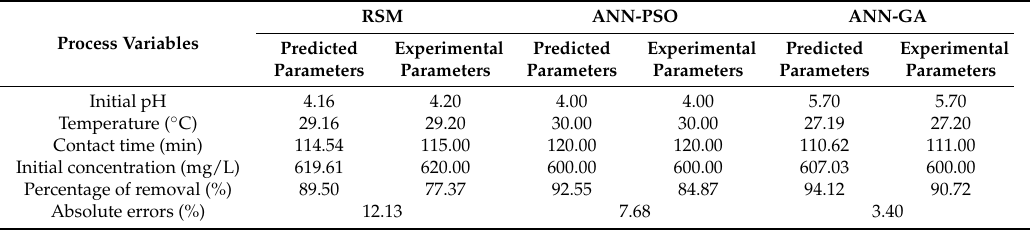
Table 6. Comparison of the confirmatory results with predicted results. RSM: Response Surface Methodology; ANN-PSO: Artificial neural network coupled with particle swarm optimization; ANN-GA: Artificial neural network coupled with genetic